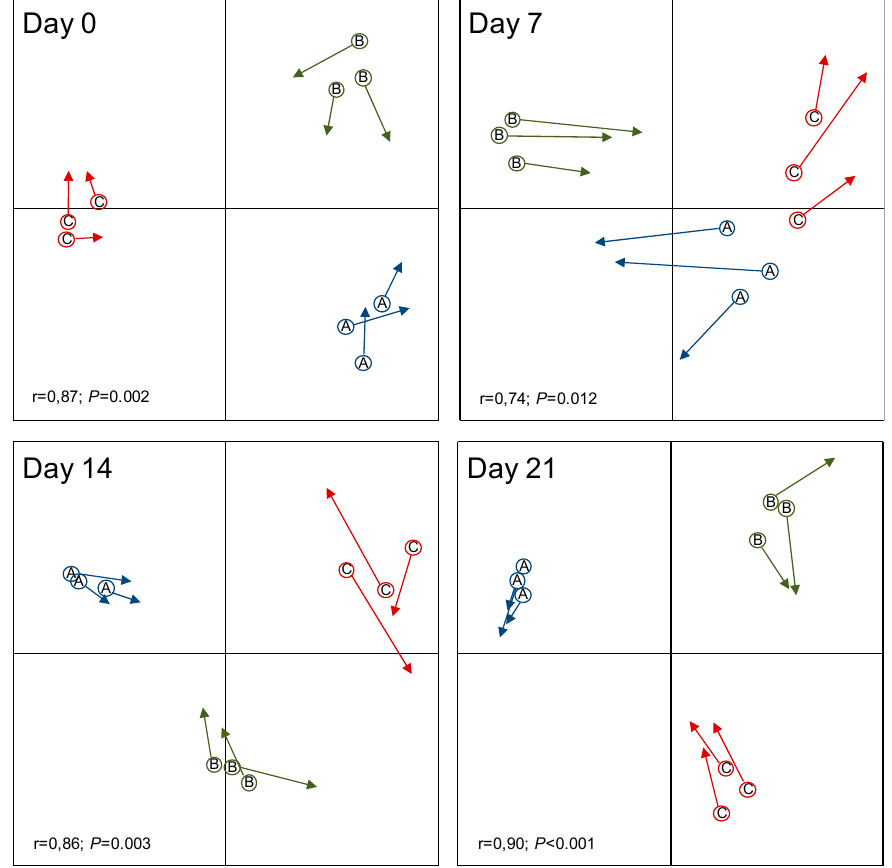
Figure 3. Procrustes analysis using the Bray–Curtis distances between the bacterial communities of the control (circles) and L. reuteri DSM 17938-inoculated skin microbiota (arrows) for each subject (A, B, C) after 0, 7, 14, and 21 days of the experiment. The results of the Mantel test (lower left corner) showed a significant correlation between the control and treatment distance matrices.